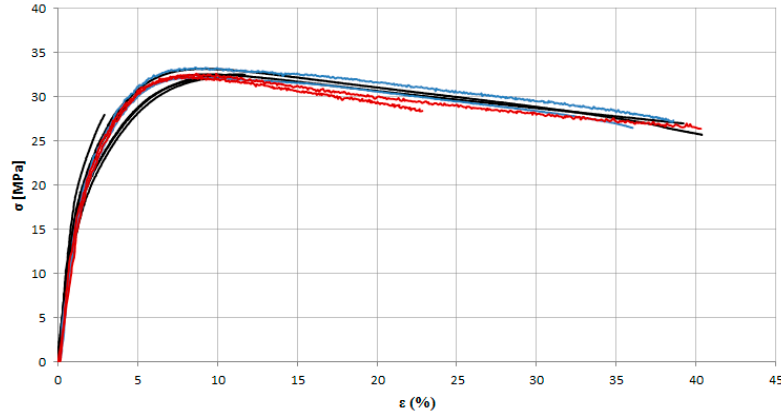
Figure 17. Stress–strain curves obtained from uniaxial tensile tests performed in the biaxial testing machine on MEB ((horizontal axis—blue curves; vertical axis—red curves) compared with the ones performed in a universal testing machine (in black).